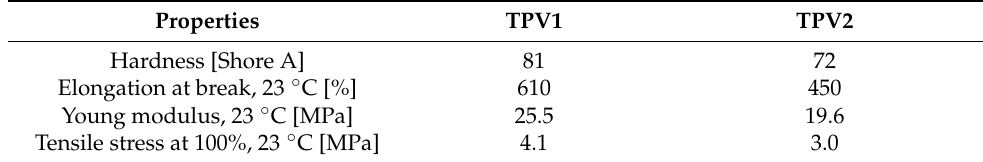
Table 1. Main properties of the studied materials.